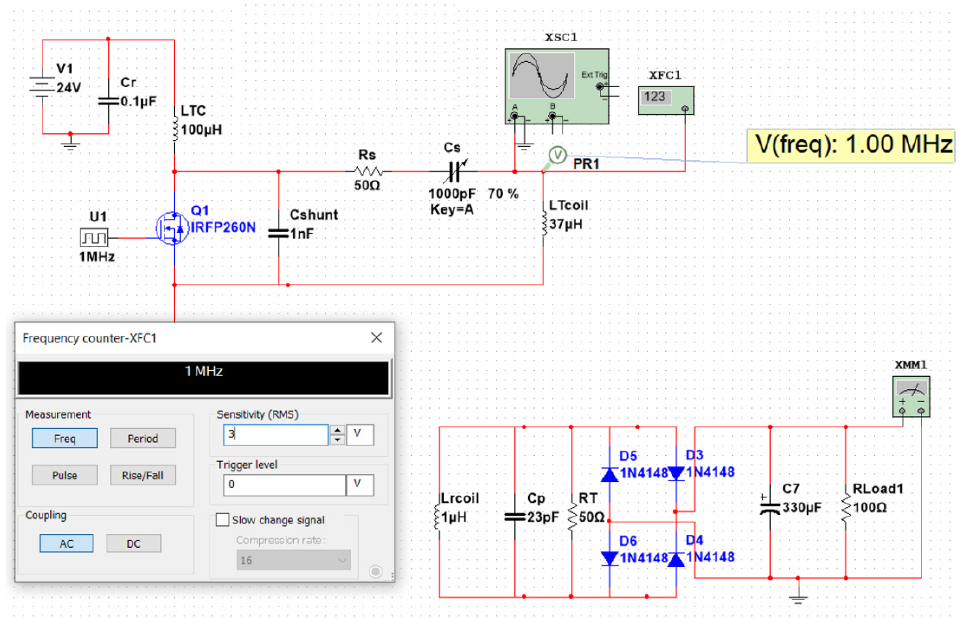
Figure 6. Circuit design using Multisim software to detect the resonance frequency.